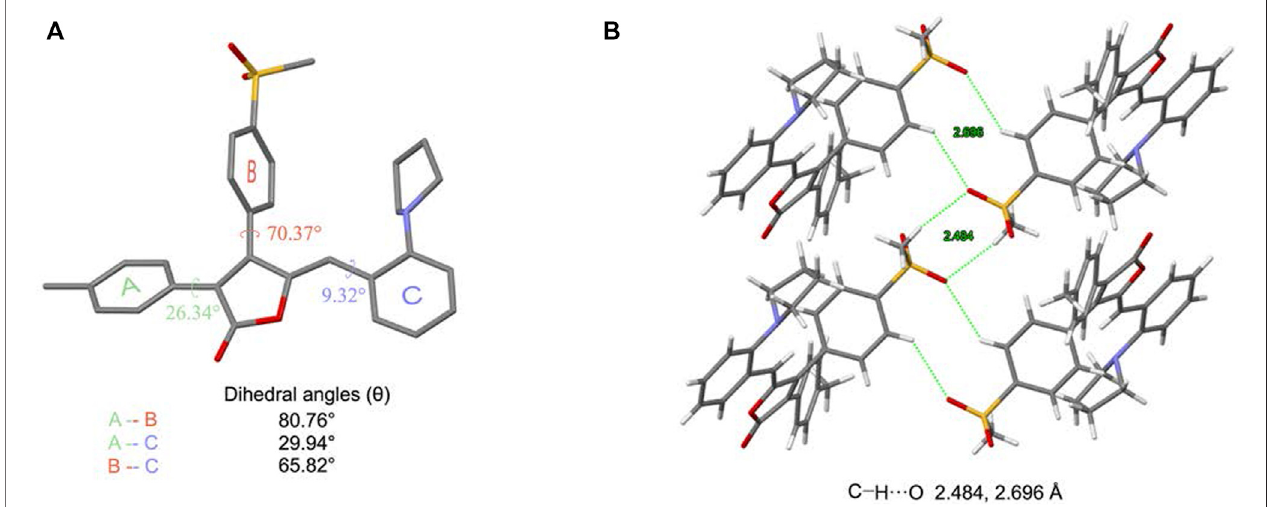
FIGURE 5 | Crystal structure of MOX2 . (A) a single molecule in the crystal strucure and relevant dihedral angles; (B) a tetramer in the crystal structure.